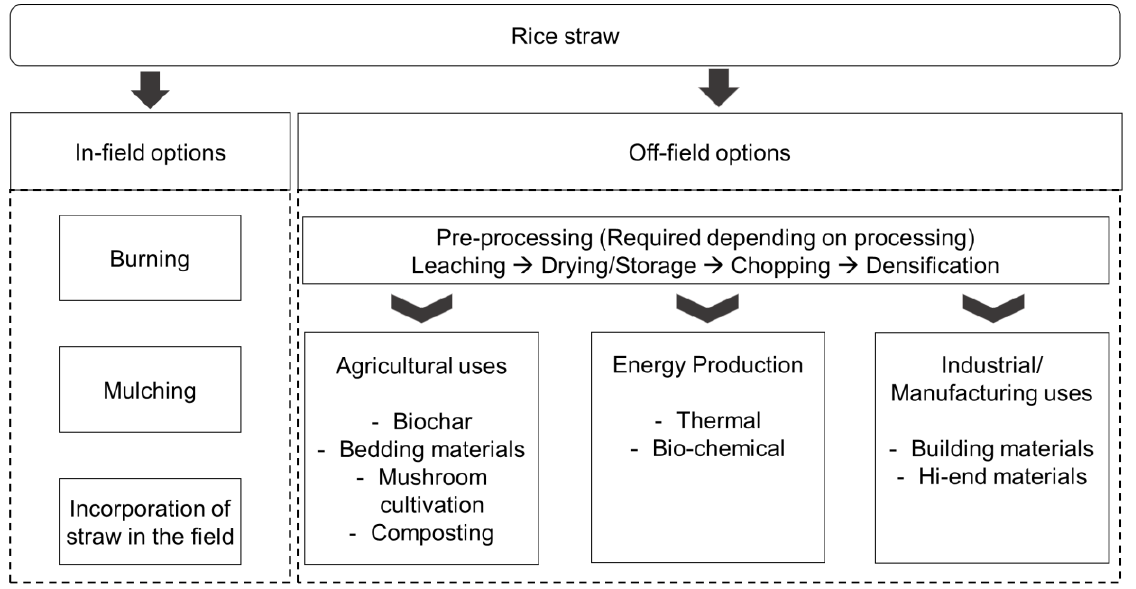
Figure 2. Overview of rice straw management options.